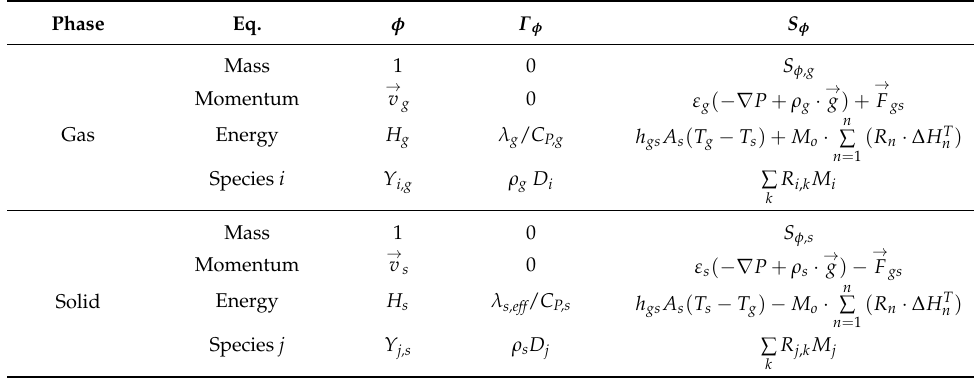
Table 1. Variables in Equation (1).